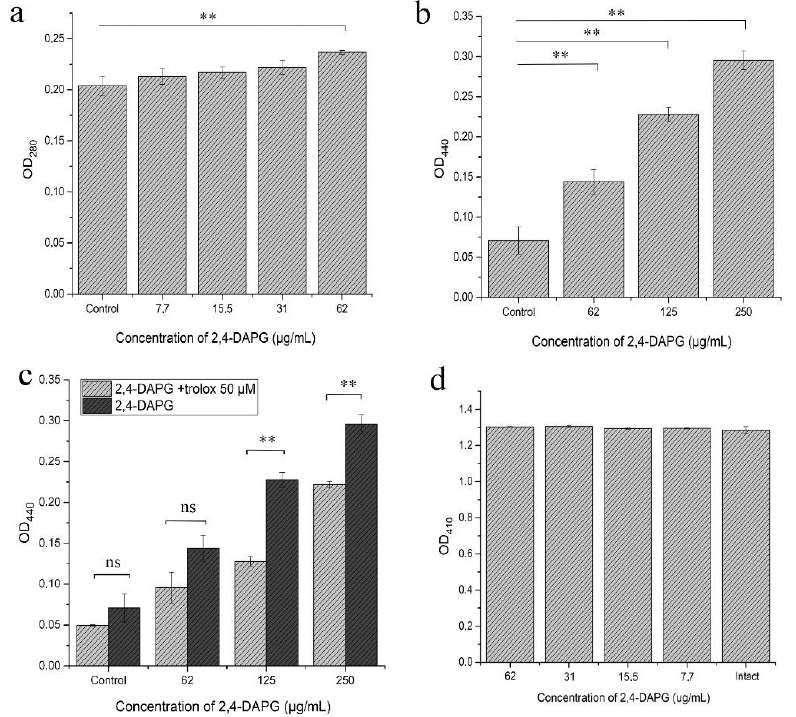
Figure 5. The protease activity of planktonic cells (Sap1–3) ( a ) and biofilms (Sap4–6) ( b ) of C. albicans ATCC 10231 under the influence of different concentrations of 2,4-DAPG. Trolox addition (50 µM) reduced Sap production ( c ). Lipase production was not affected by the action of 2,4-DAPG ( d ). The means plus standard deviations of results from two independent experiments with three technical replicates are shown. Values that are significantly different from the values for “control” are indicated ** p < 0.01, ns—values are not significantly different (pair-sample Student’s t -test).